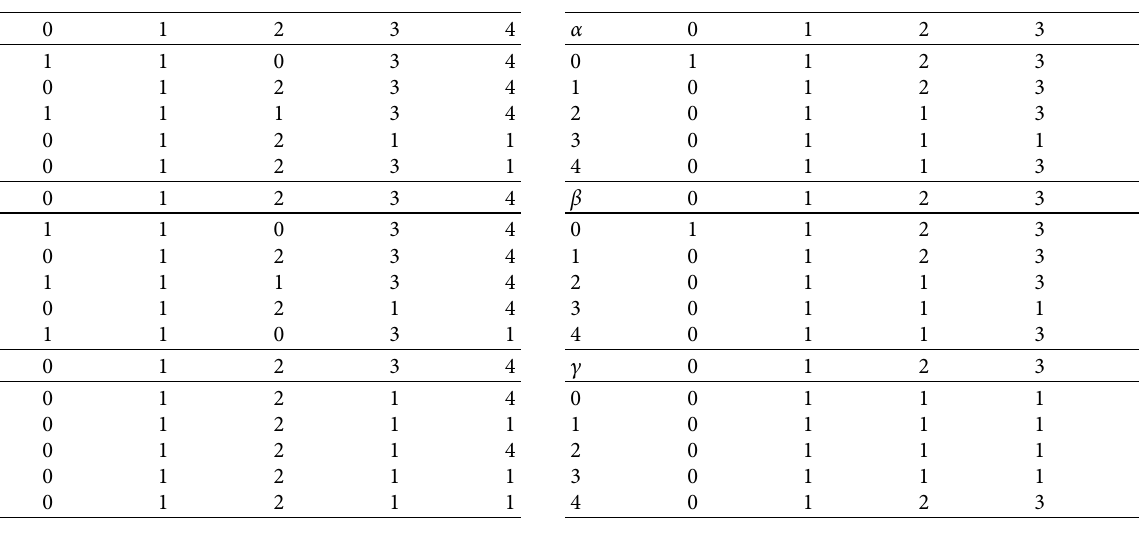
Table 15: Cayley tables for the binary operations “ α , β , and c .” Table 16: Cayley tables for the binary operations “ α , β , and c